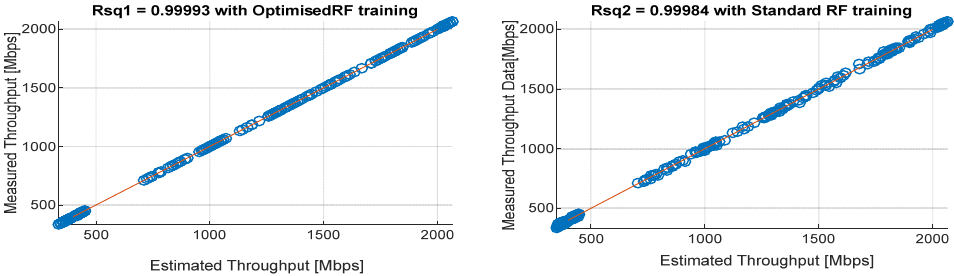
Figure 14. Predicted throughput quality correlation performance of the proposed RF-LS-BPT model and standard RF model at 50 m distance.